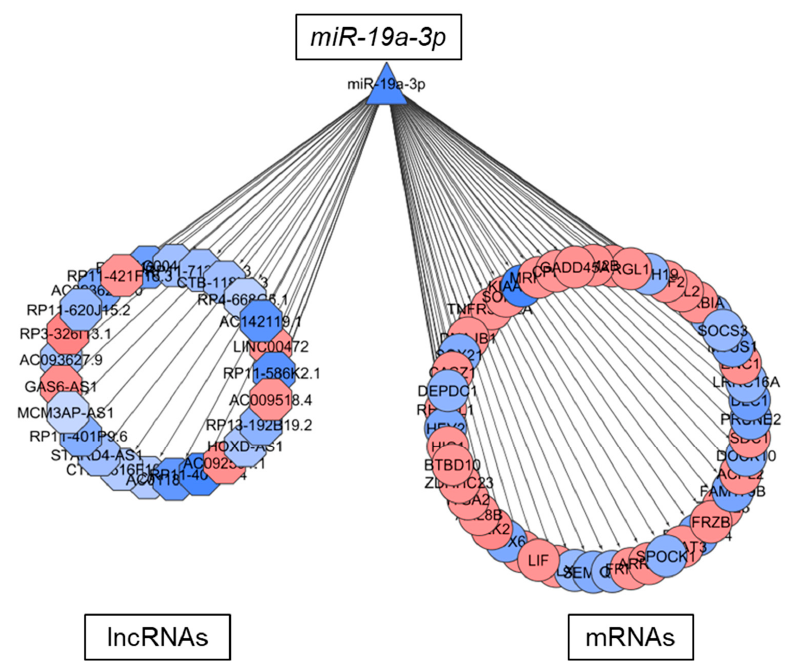
Figure 6. Putative ceRNA function of lncRNAs regulated by TMZ. Gene regulatory network representing the molecular associations between miR-19a-3p and mRNAs or lncRNAs in NCH601. the molecular associations between miR-19a-3p and mRNAs or lncRNAs in NCH601. Up- and Up- and downregulated RNAs are shown in red and blue, respectively. Different node shapes downregulated RNAs are shown in red and blue, respectively. Di ff erent node shapes distinguish RNA distinguish RNA families; TF: square, miRNA: triangle, mRNA: circle, lncRNA: hexagon. families; TF: square, miRNA: triangle, mRNA: circle, lncRNA: